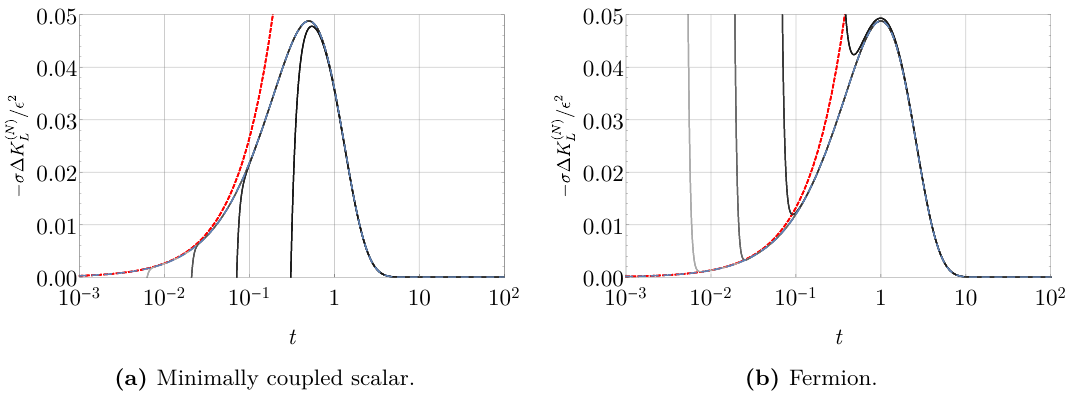
Figure 16. The convergence of the numerically-computed truncated heat kernel ∆ K ( N ) perturbative results, for the ‘ = 3 deformation (4.9) with (cid:15) = 0 . 01 . The blue dashed curves show the perturbative heat kernels (3.15) and (3.22), while the dark to light gray curves show the truncated differenced heat kernel for N = 10 , 20 , 40 , 80 . As in figure 15 we see that accuracy at small t requires larger N . We also show the leading linear behavior ∆ b 4 t from the heat kernel expansion (dashed,